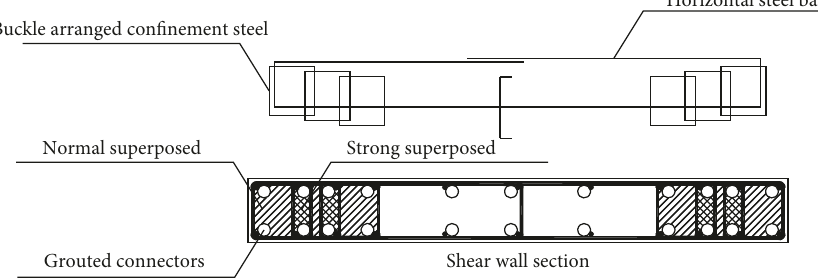
Figure 2: Buckle arranged confinement steel hoops and the superposed